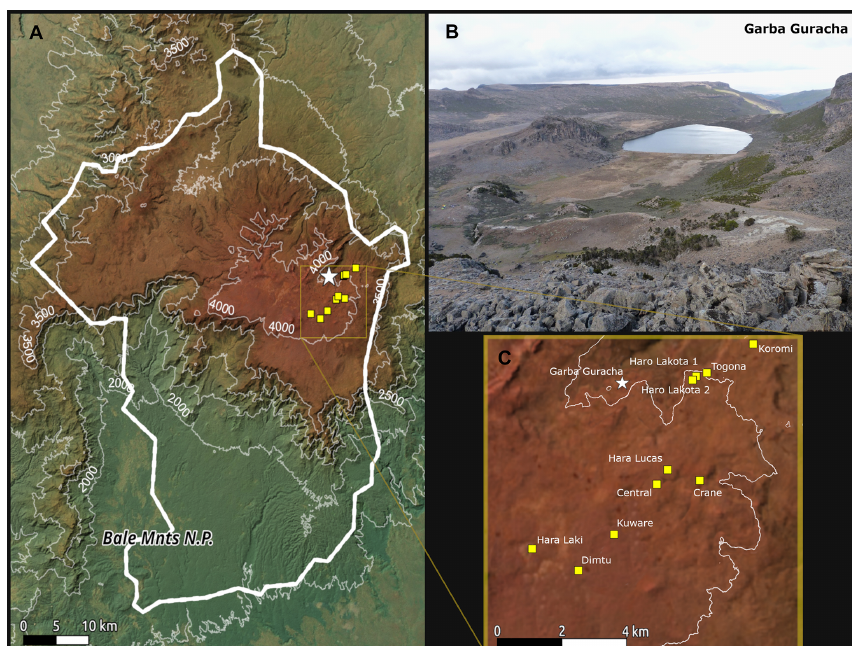
Figure 1. Location of the study area. (a) Bale Mountains National Park (thick white line); (b) a northeastward view over the glacial cirque of the Garba Guracha catchment (Bittner et al., 2021), and (c) Bale Mountains lakes in the dataset (yellow) – the map was created by the authors using QGIS 3.24 Tisler. All map layers are CC BY-SA v4.0; image is from Bing/DigitalGlobe © Microsoft; DEM is from NASA JPL SRTM (http://www.jpl.nasa.gov/srtm/, last access: 1 April 2022); the Bale Mountains National Park boundaries are from © OpenStreetMap contributors 2019. Distributed under the Open Data Commons Open Database License (ODbL)